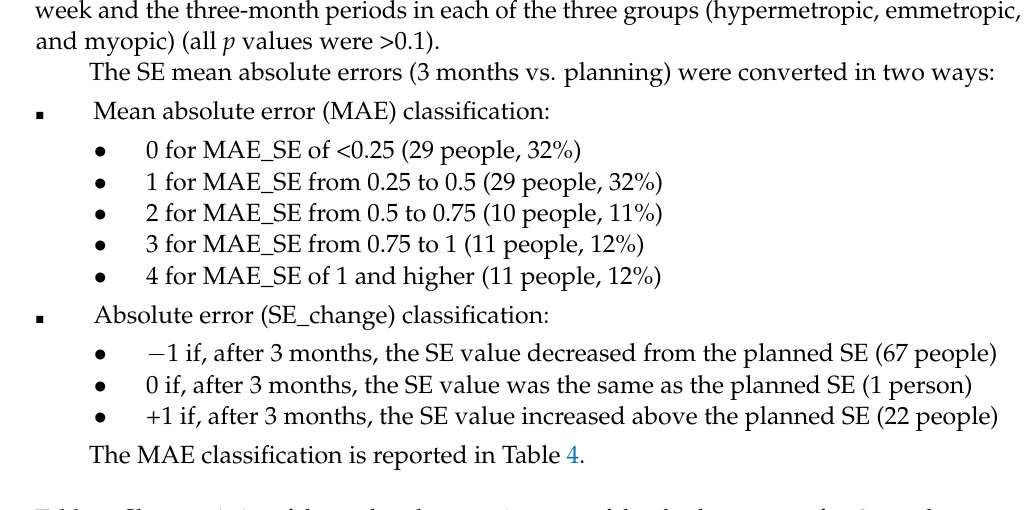
Table 4. Characteristics of the analysed groups in terms of the absolute errors after 3 months.